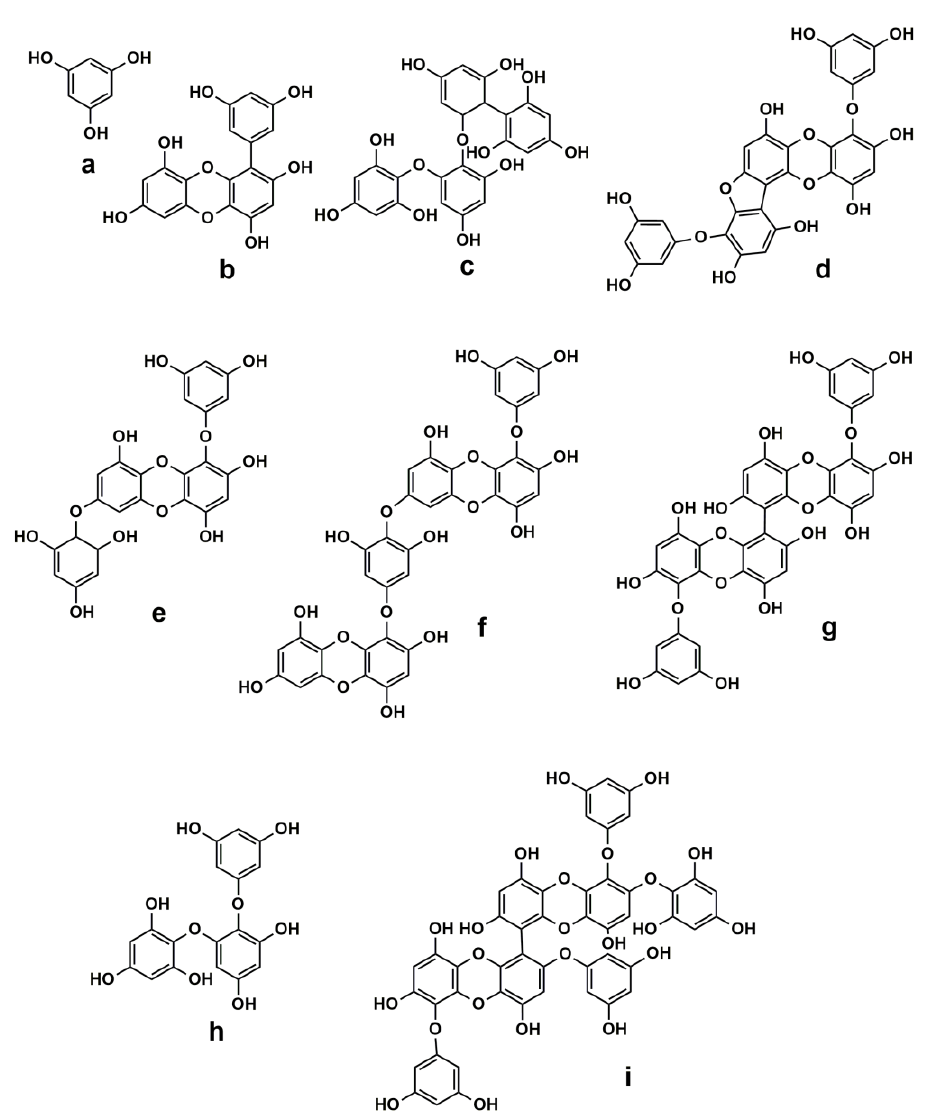
(c) fucodiphlorethol G; (d) phlorofucofuroeckol A; (e) 7-phloroeckol; (f) dieckol; (g) 6,6′-bieckol; (h) triphlorethol-A; and (i) 2,7′-phloroglucinol-6,6′-bieckol (Figure 1) [42,62,67–71], could act as effective reductants to synthesize noble metal NPs.